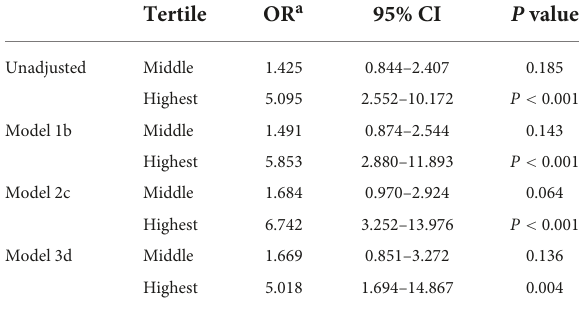
TABLE 4 Multivariate logistic regression analysis for depression in stroke patients.